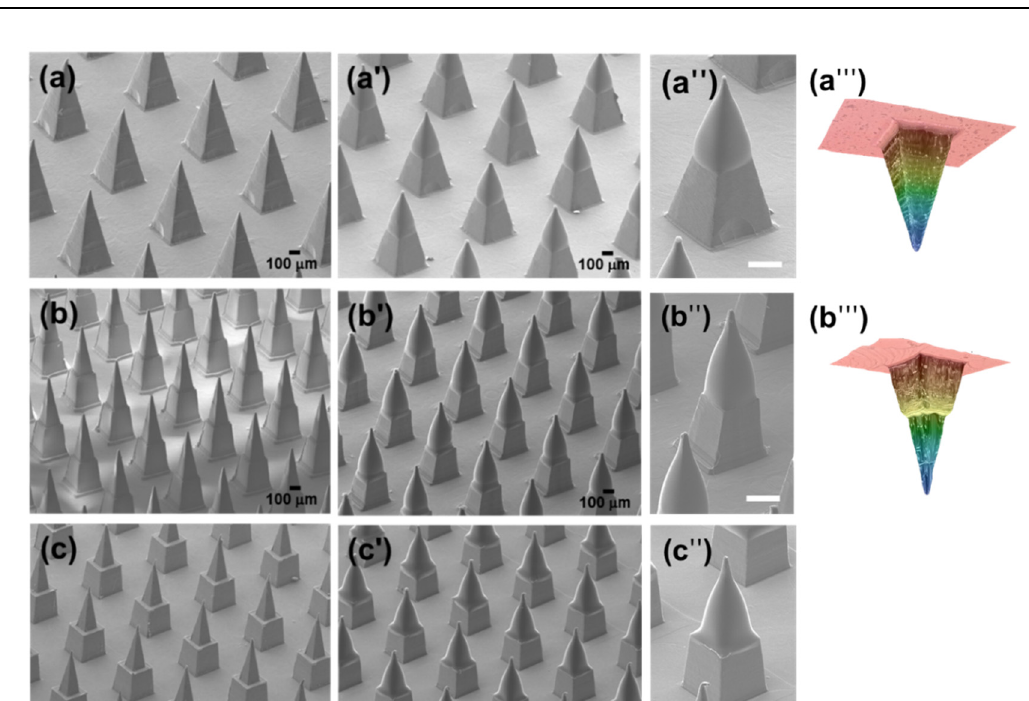
Figure 1. SEM image of u-MNs with ( a ) aspect ratio 2.2; ( b ) aspect ratio 2.5; ( c ) aspect ratio 3.0; c-MNs with ( a’ ) aspect ratio 1.3; ( b’ ) c-MNs aspect ratio 1.4; ( c’ ) c-MNs aspect ratio 1.6; Magnified image of c-MNs with ( a’’ ) aspect ratio 1.3; ( b’’ ) aspect ratio 1.4; ( c’’ ) aspect ratio 1.6. White scale bar means 200 μ m. Laser microscopic image of microneedle cavity of mold of ( a’’’ ) u-L-MNs (aspect ratio 2.2) and ( b’’’ ) u-M-MNs (aspect ratio 2.5).